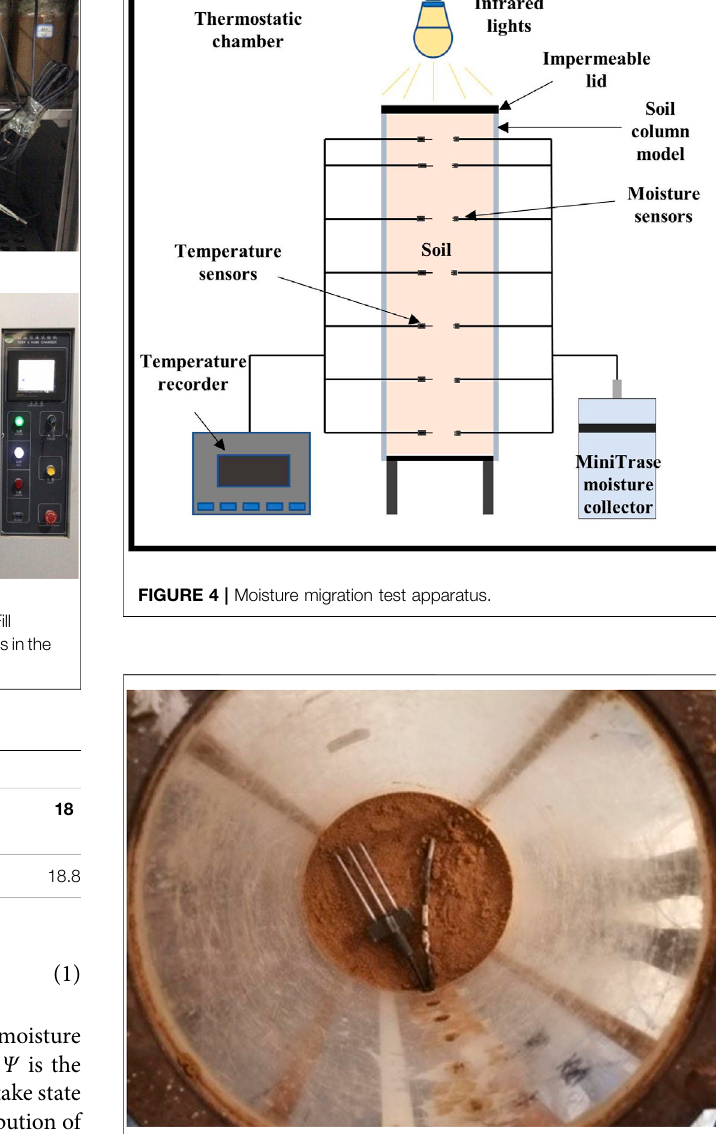
FIGURE 5 | Arrangement of